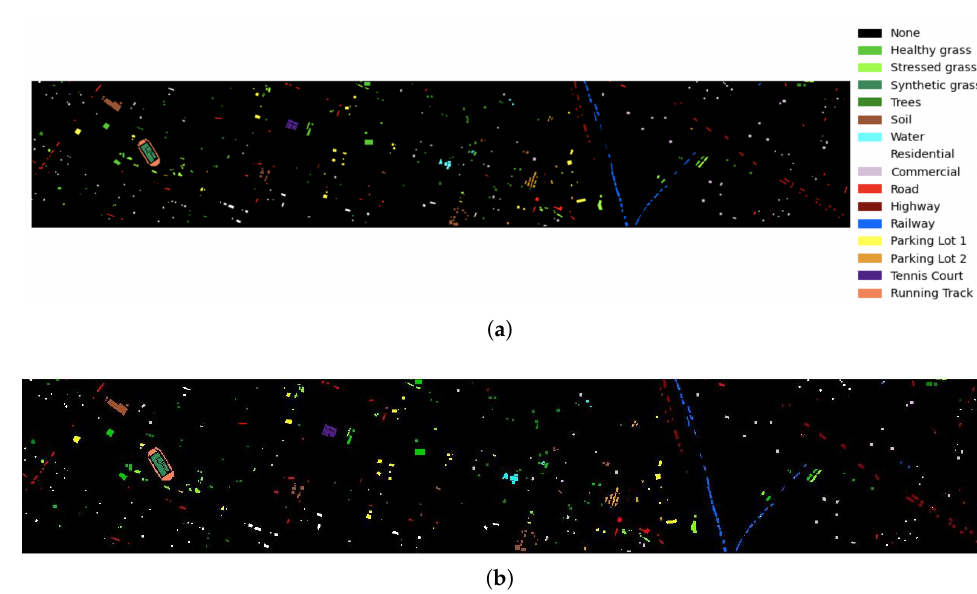
Figure 8. Classification map for Houston university. ( a ) Groundtruth map. ( b ) AN-GCN. Table 8. classification performance(%) of various GCN methods for Houston University